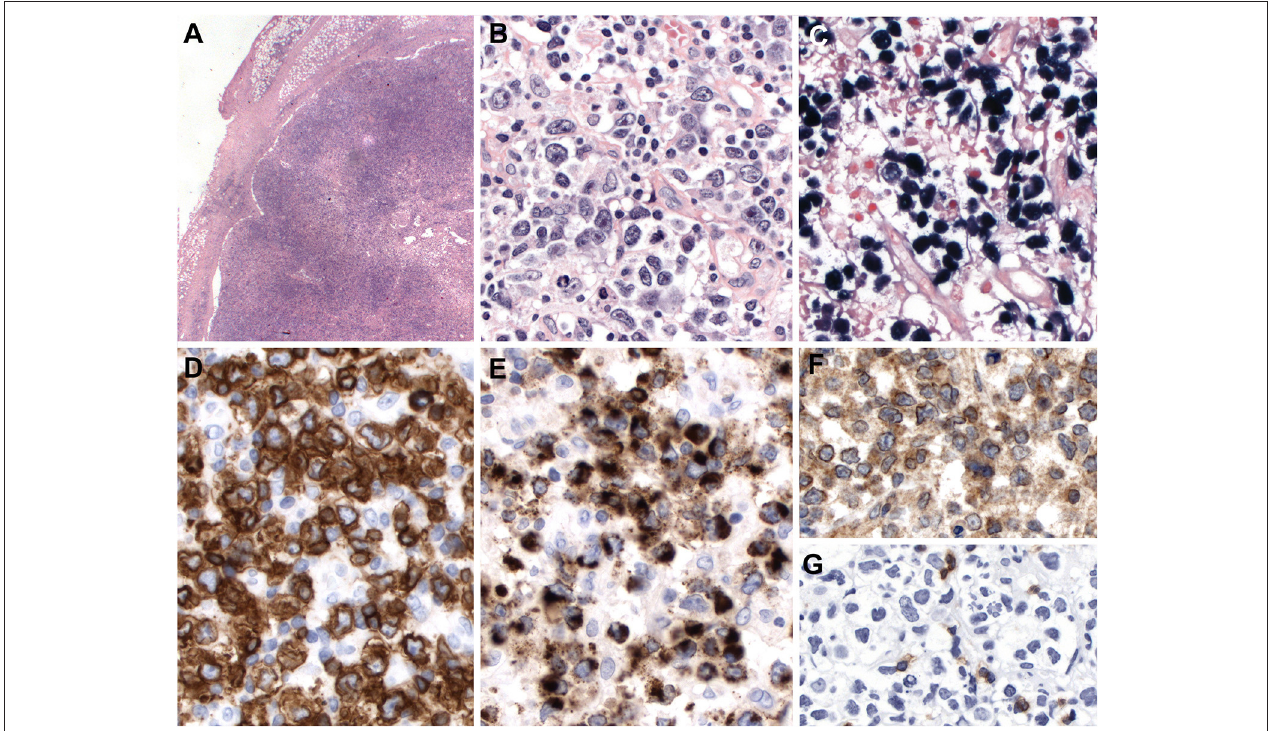
FIGURE 6 | Primary EBV-positive nodal T and NK-cell lymphoma. (A) Lymph node with complete effacement of the architecture by a diffuse infiltrate that extends beyond the capsule and infiltrate the perinodal fat (H&E, 12,5 × ); (B) Neoplastic cells are large, pleomorphic with irregular nuclei and clear or pale cytoplasm (HE,400 × ); (C–E) The neoplastic cells EBER, CD56 and TIA-1 positive ( in-situ hybridization and immunohistochemistry, 400 × ); (F) TCR-gamma immunostain demonstrates the gamma-delta derivation of the tumor cells (immunohistochemistry, 400 × ); (G) TCR alpha-beta (BetaF1) is negative in the tumor cells but positive in the reactive T cells (immunohistochemistry, 400 ×